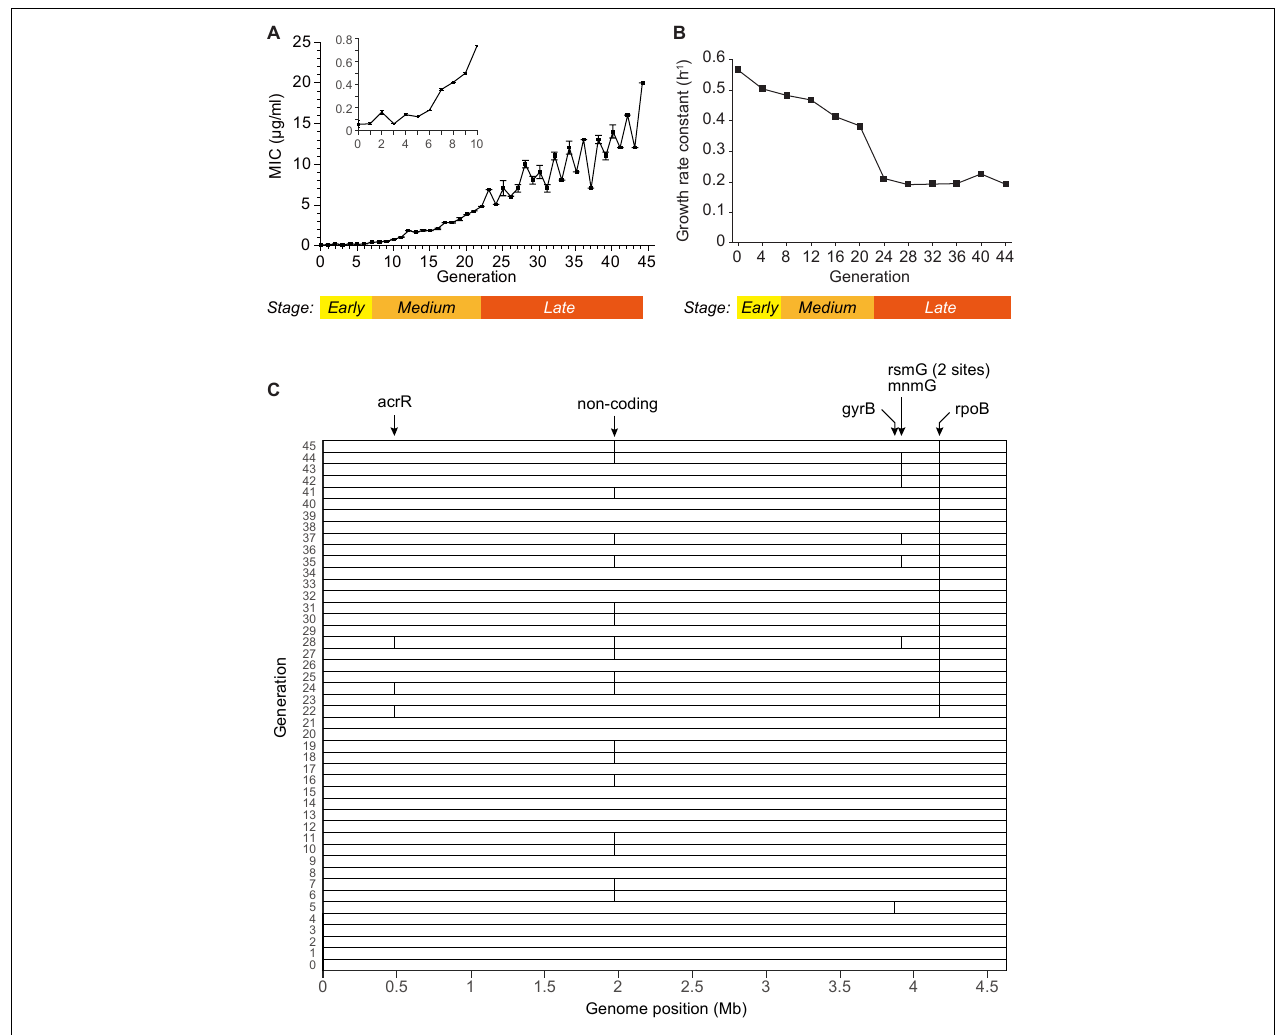
FIGURE 1 | Subculturing E. coli BW25113 in the sub-lethal concentration of CIP. (A) The MIC of each generation. (B) The growth rate constant measured every 4 generations. (C) Single nucleotide mutations detected in the WGS of each generation, marked as vertical bars. The affected genes were marked on the top. Some closely located mutations are not distinguishable in the figure due to the limited resolution. Detailed information of each mutation is listed in Supplementary Table 2